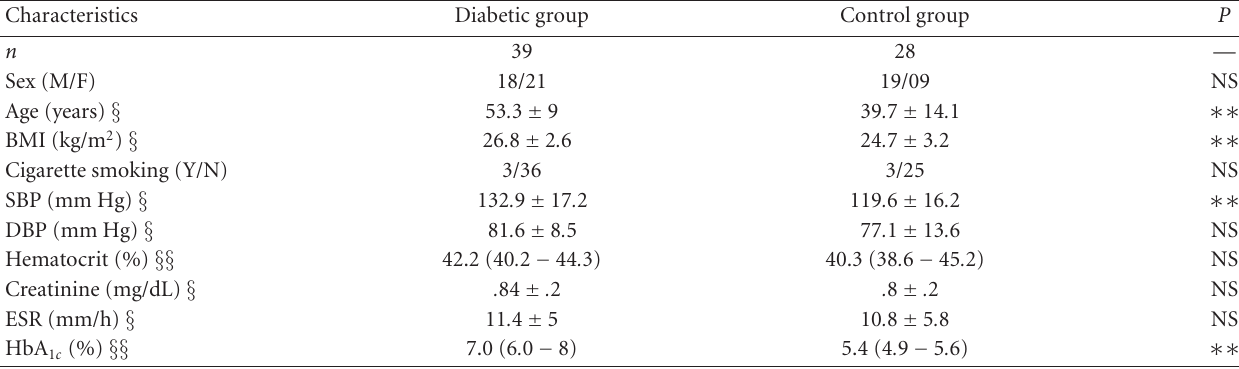
Table 1: Clinical and laboratory characteristics of the studied groups. n = number of subjects, F = female, M = male, Y/N = yes/no, NS = not significant, BMI = body mass index, SBP = systolic blood pressure, DBP = diastolic blood pressure, ESR = , erythrocyte sedimentation rate ∗∗ = P < . 01, § = mean ± SD, §§ = median (with the 25th and 75th centiles-quartiles), P values obtained from either unpaired Student t test, λ 2 test, or Mann-Whitney U